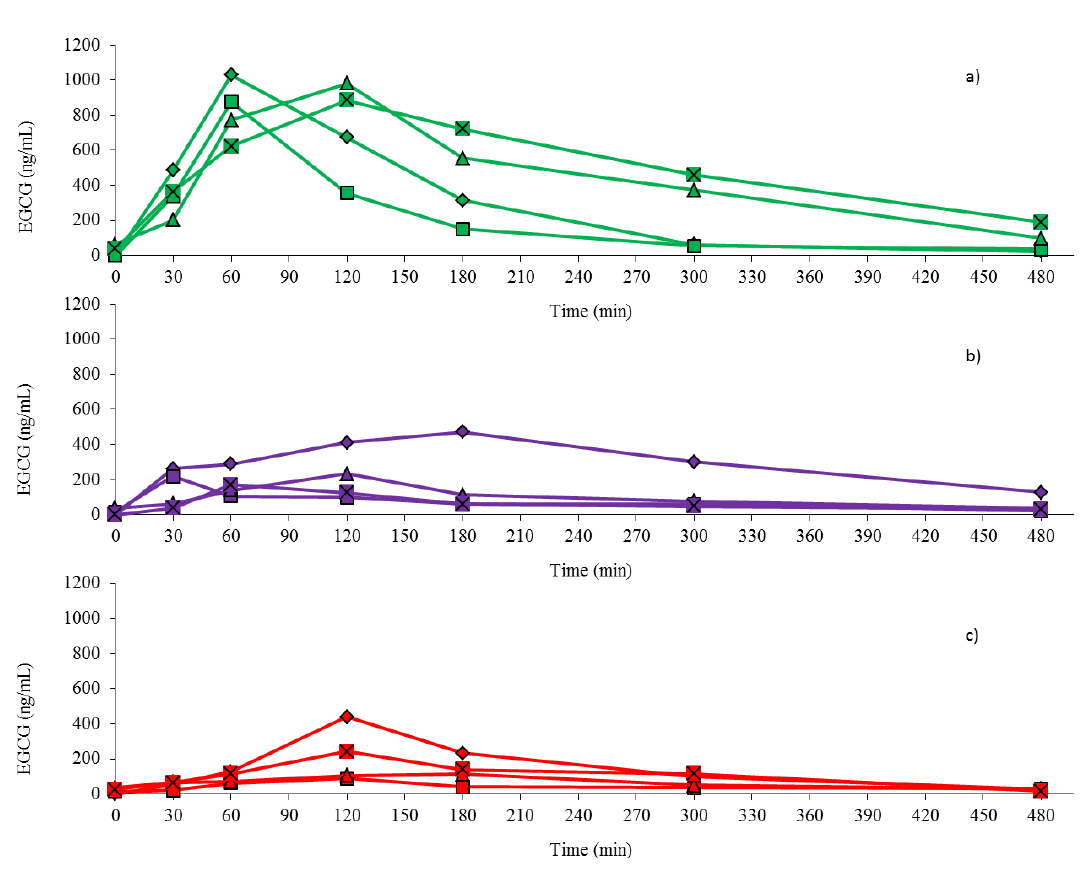
Figure 4. Plasma EGCG concentration-time curves for each of the four individual participants for the three different methods of EGCG oral delivery: ( a ) capsules without breakfast; ( b ) capsules with breakfast; and ( c ) strawberry